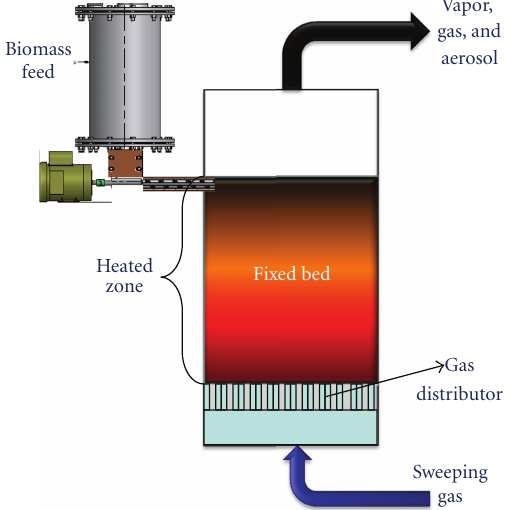
Figure 2: Fixed bed reactor concept for biomass